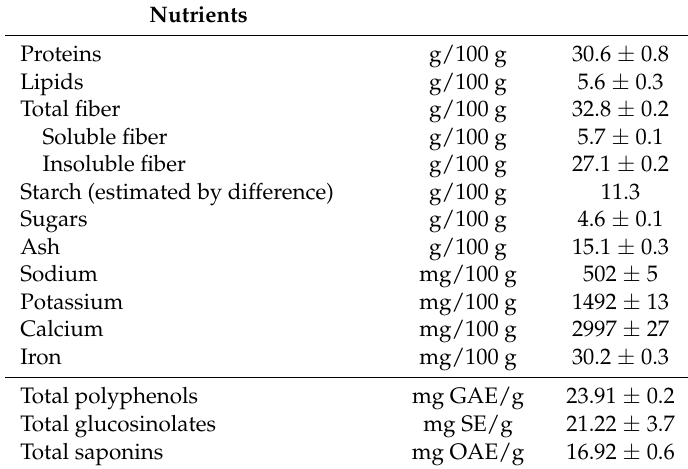
Table 1. Nutritional-chemical composition of Moringa oleifera (MO) leaf powder.